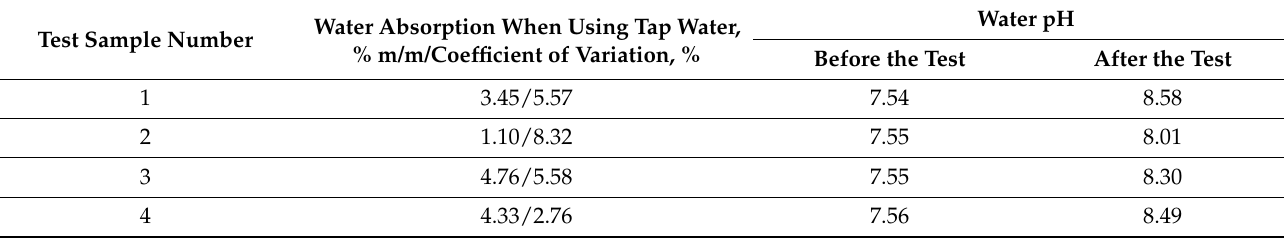
Table 3. Results of tap water absorption test of polymer modified bituminous thick coatings. Test Sample Number